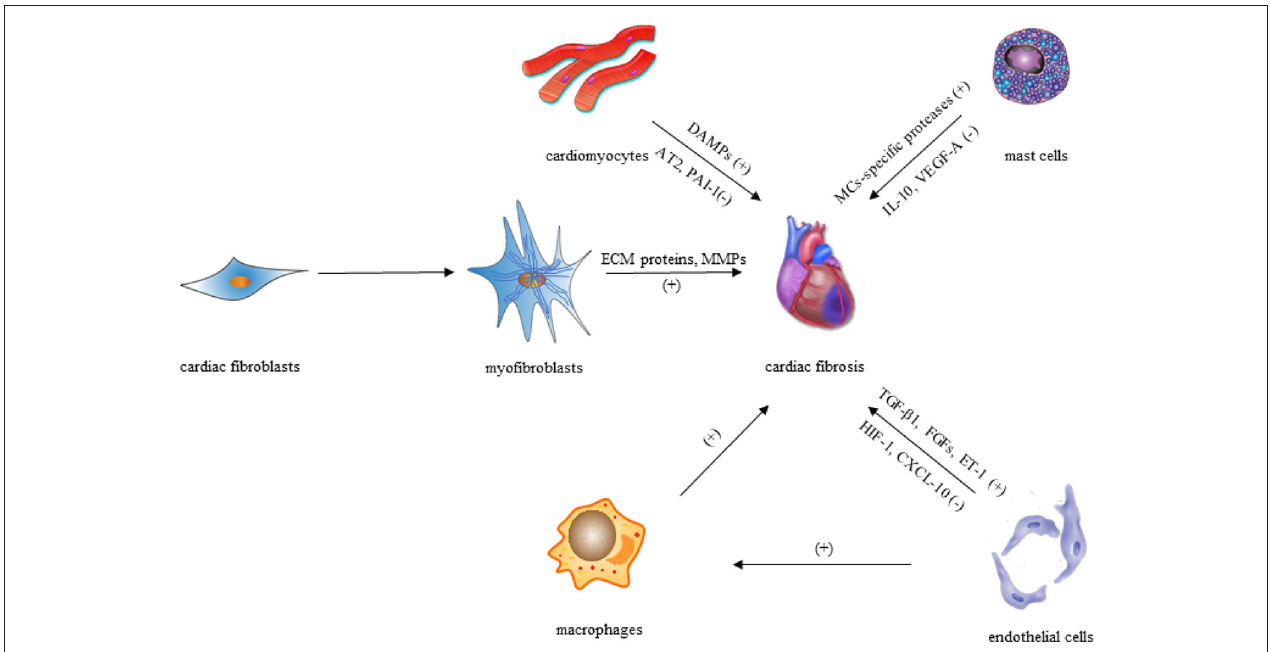
FIGURE 1 | Cellular effectors of cardiac